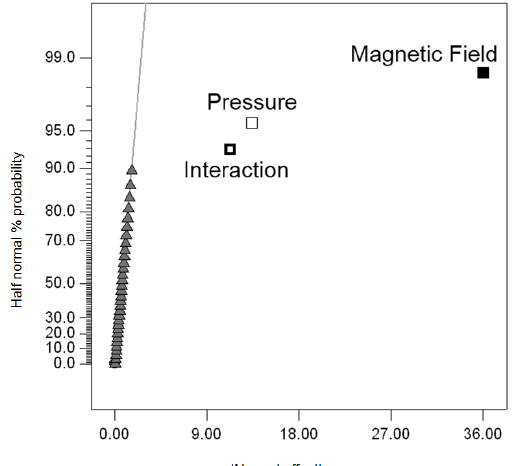
Figure 7: Half normal plot of the yield shear stress: effect of the magnetic field (black square), pressure (white square) and their interaction (hollow black